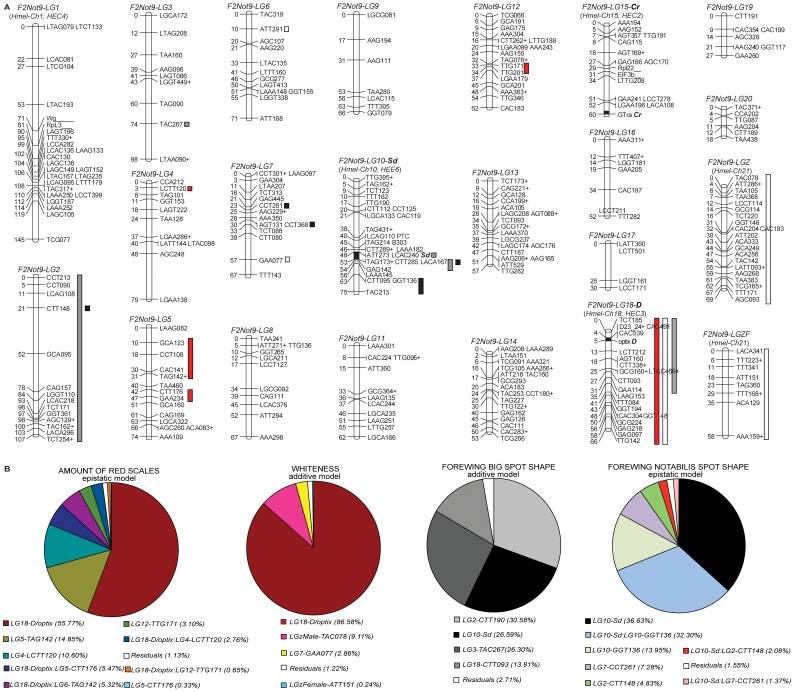

F2-Not9 linkage map and overall QTL analysis.(A) F2-Not9 linkage map and overall QTL analysis of the H. himera×H. erato notabilis cross showing the 20 autosomal and two sex linkage groups generated with AFLP and co-dominant anchor loci (Tables S5, Table S6, Table S7, and Table S8). Numbers of the left side represent distance in cM rounded to the closest integer value, while letters on the right side represent marker names. Approximate positions of major color pattern genes (Sd-LG 10, D-LG 18, Cr-LG 15) are indicated with a black square within each linkage group. Vertical bars next to the chromosomes represent QTL regions with colors corresponding to phenotypes measured: red bars = redness; white bars = whiteness; grey bars = Big-Spot (BS); and black bars = Not-Spot (NS). (B) Pie charts show the relative contributions of individual markers to the total variance explained when all significant QTLs were analyzed under the best model (additive or epistatic). Note that F2-Not9 LG 1, LG 10, LG 18 and LG 15 correspond to LG 4, LG 3, LG 6 and LG 2 in Kapan et al. (2006) and to LG 1, LG 10, LG 18 and LG 15 in Jiggins et al. (2005) respectively. Linkage analysis and autosomal LG numbers for the F2-NotF29 reference map are arranged with the same numbers as H. melpomene when homology could have ben established.